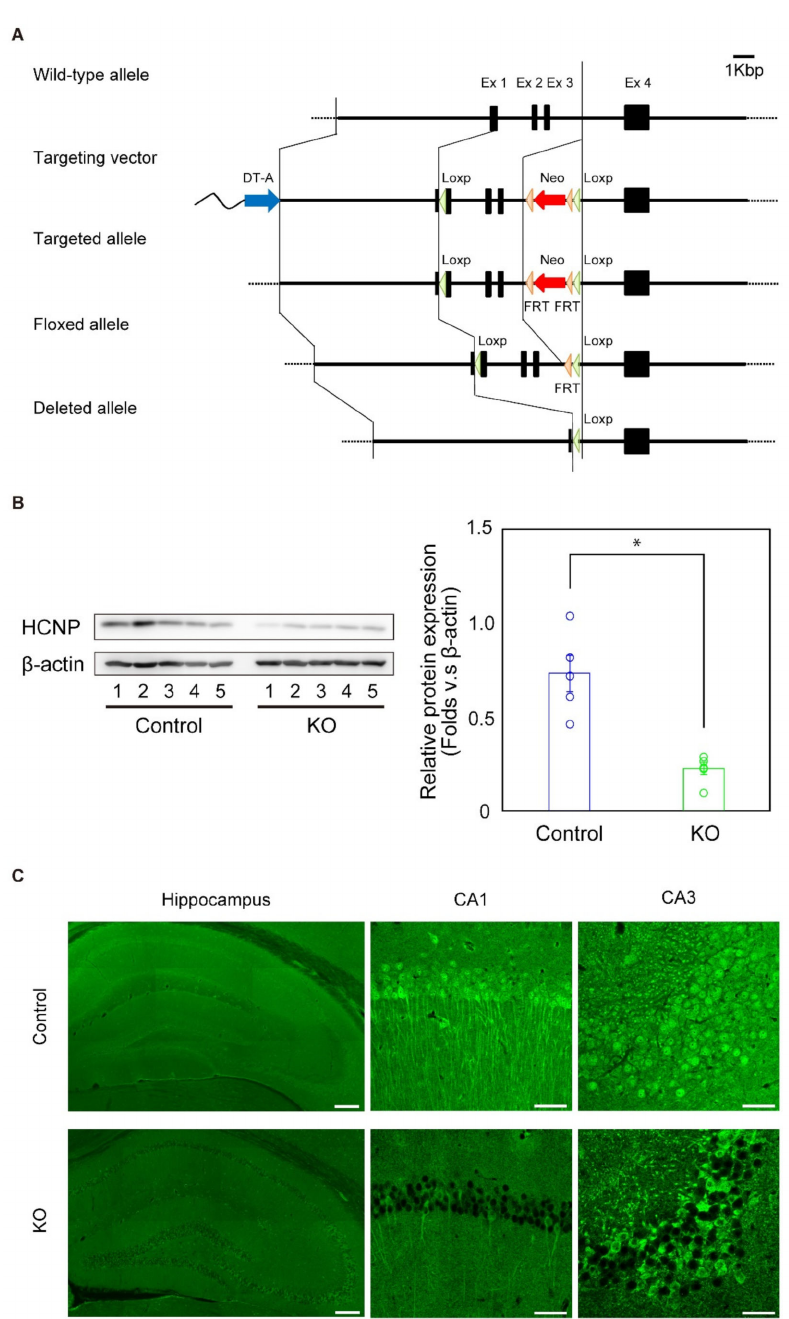
Figure 1. ( A ) Knockout of the HCNP-pp ( PEBP1 ) gene by Cre recombinase. Tamoxifen was injected into floxed HCNP-pp mice, which expressed Cre-ERT, 3 months after birth. The HCNP-pp gene was excised between the middle portion of exon 1 and the intron between exons 3 and 4 by Cre recombinase. ( B ) Evaluation of HCNP-pp levels by western blotting (left) with quantification (right). Five controls and five HCNP-pp KO mice were examined. HCNP-pp KO mice had significantly reduced levels of HCNP-pp (Student’s t -test, * p < 0.01). Scanned images of unprocessed blots are shown in Figure S1. ( C ) Immunohistochemical staining of the hippocampus with an anti-HCNP-pp antibody. HCNP-pp expression was mainly decreased in hippocampal pyramidal cell bodies and apical dendrites and in granular cells of the dentate gyrus in HCNP-pp KO mice. Scale bar = 200 µ m (left), 50 µ m (middle and